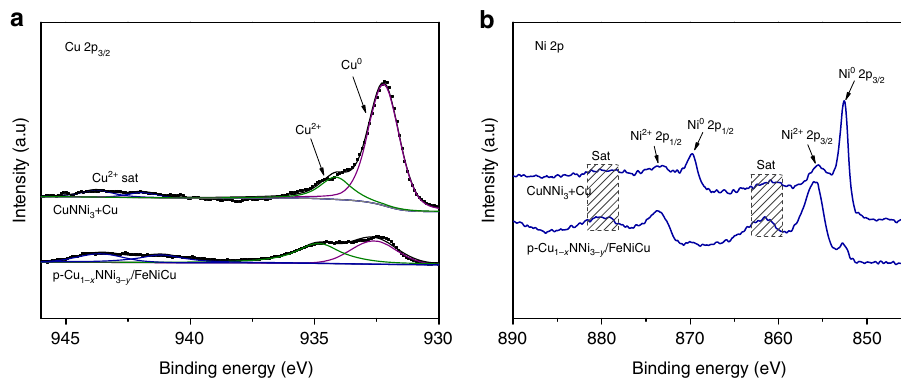
Fig. 4 XPS characterization. a Cu 2p 3/2 and b Ni 2p XPS spectra of the CuNNi 3 + Cu and p-Cu 1 − x NNi 3 − y